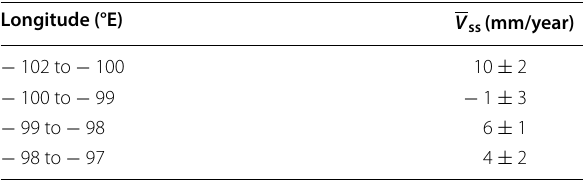
Table 3 Mean strike-slip components of the Xolapa sliver motion ( V ss ) for the earthquakes grouped in longitude ranges, calculated using data from Global CMT